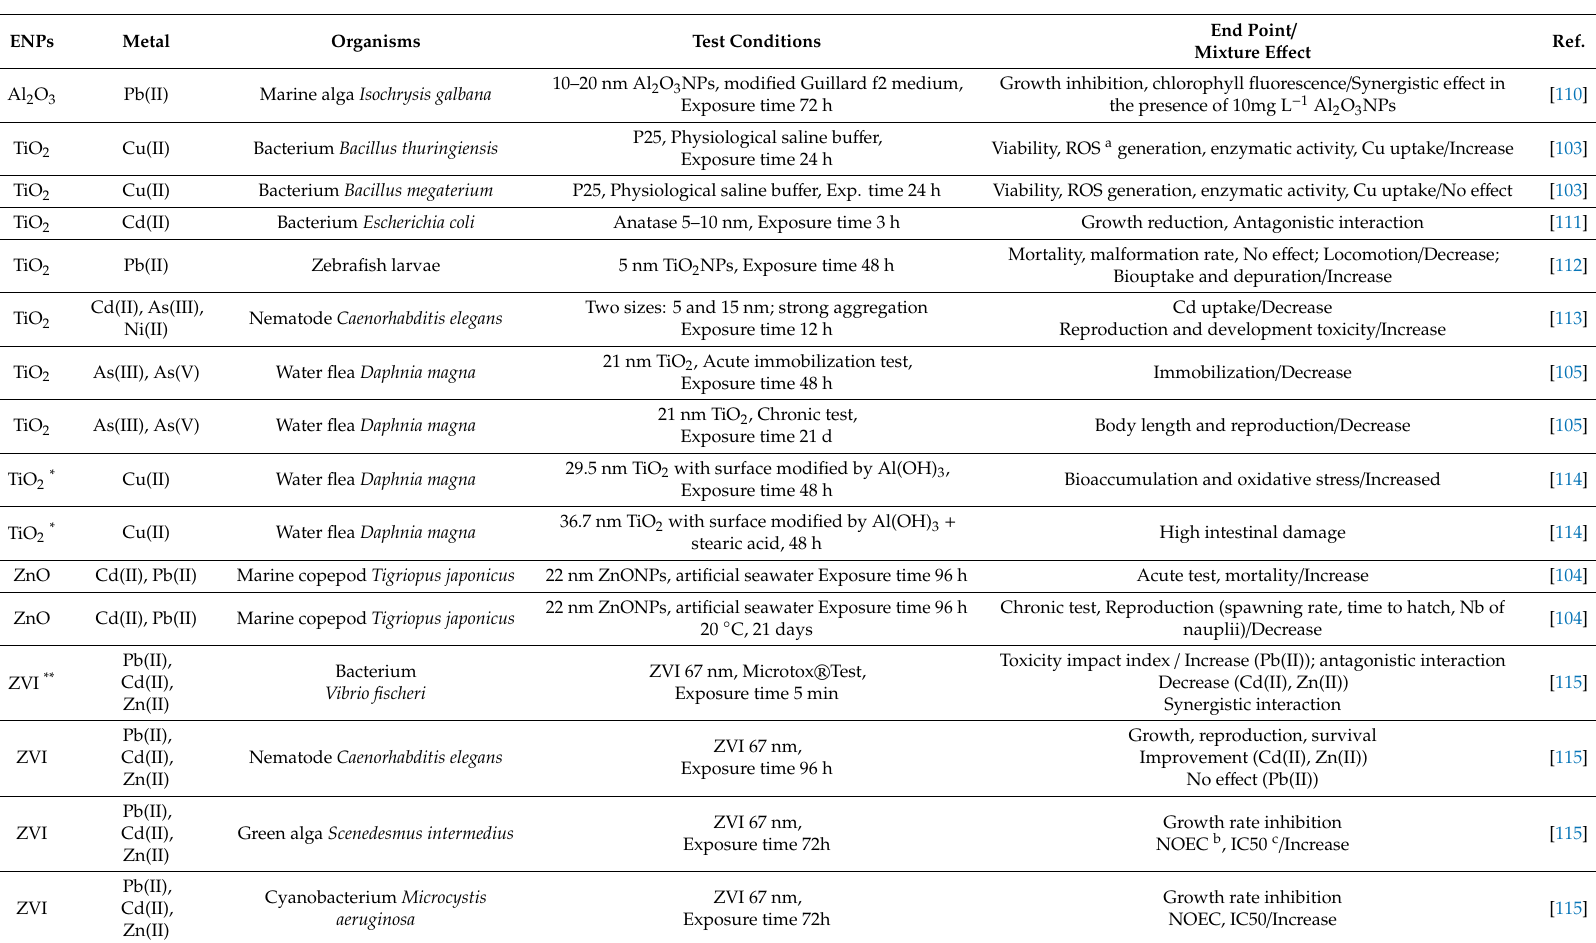
Table 1. Selected recent examples of studies investigating the combined e ff ects of metals and ENPs on plankton species including algae, bacteria, ciliate and